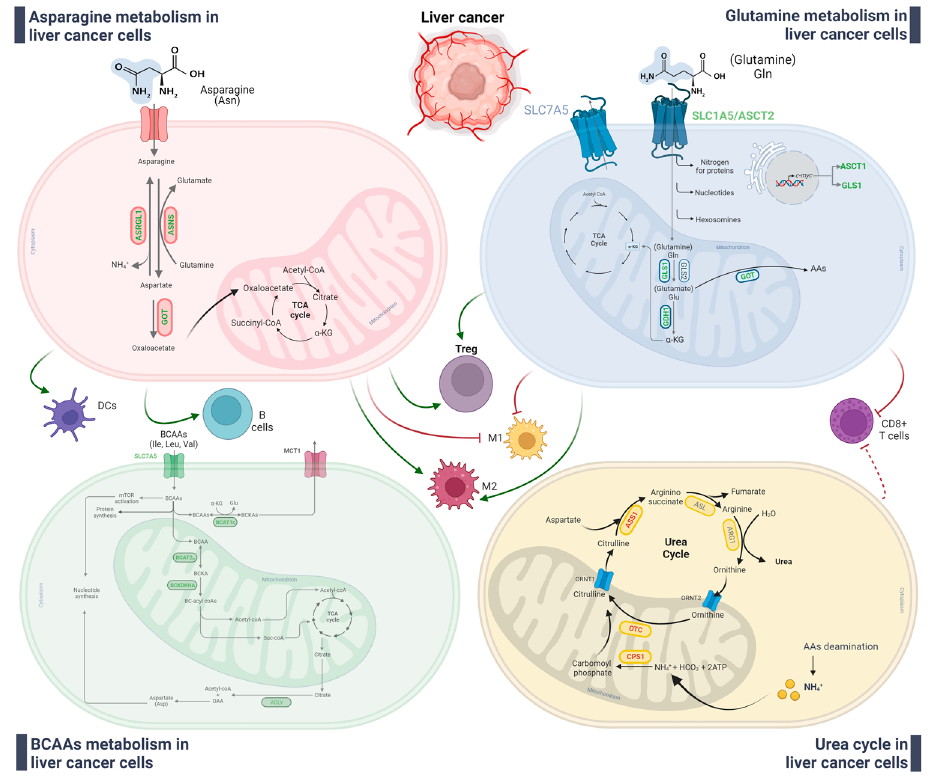
Figure 3. Metabolic rewiring of AAs in liver cancer cells and effects on immune cells infiltration. As illustrated in the review’s text, deregulation of AAs can affect the recruitment and/or the functionality of immune cells, potentially favor immune escape of liver cancer cells. Abbreviation: ASRGL1, L-asparaginase; ASNS, asparagine synthetase; GOT, aspartate aminotransferase; SLC7A5, solute